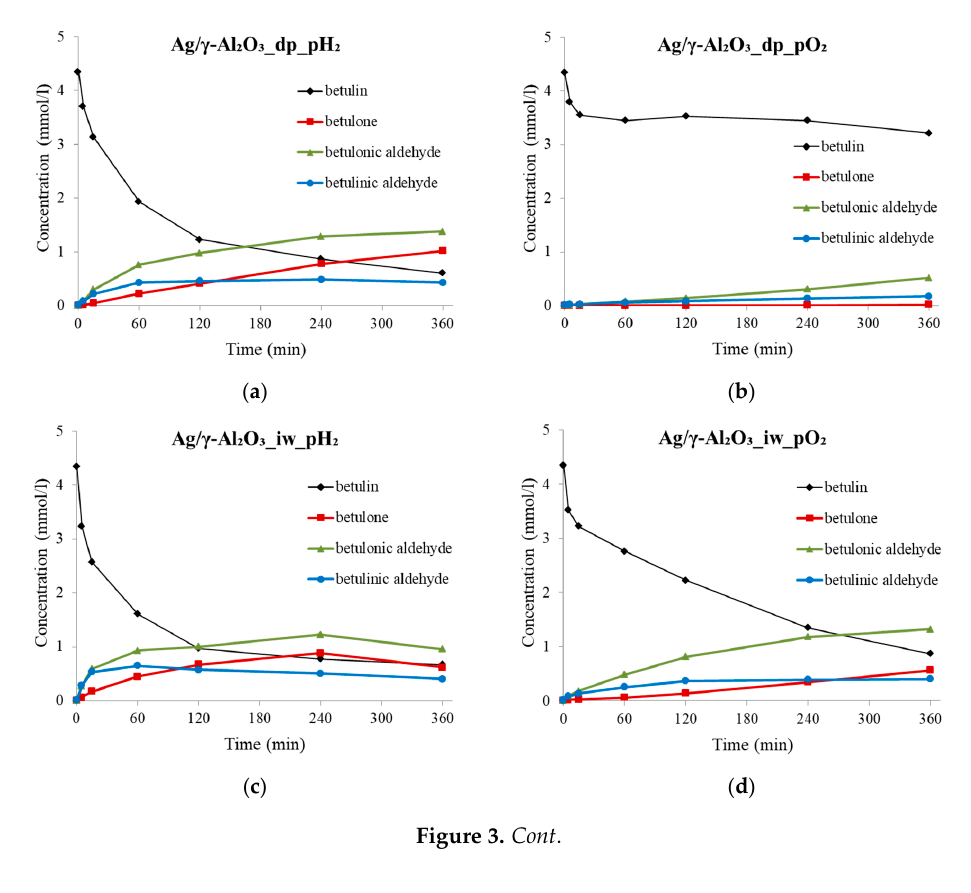
Table 3. С atalytic results for betulin oxidation over Ag